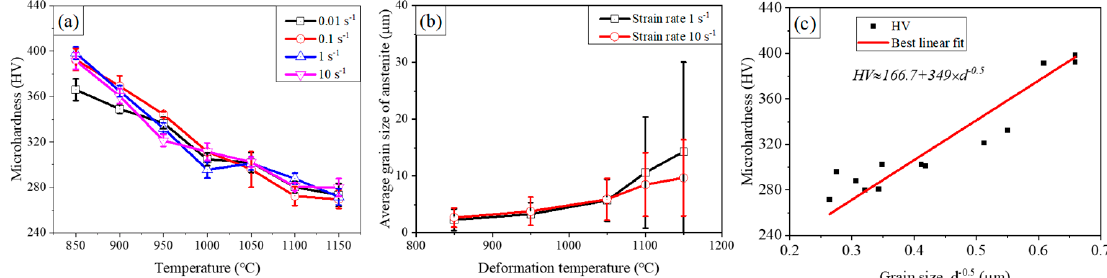
Figure 9. Dependence of microhardness and grain size of Fe-30Mn-11Al-1C-0.1V-0.1Nb low density steel after thermal processing. ( a ) Microhardness after thermal process with different processing conditions, ( b ) Grain size as a function of deformation temperature and ( c ) Relationship between microhardness and grain size.